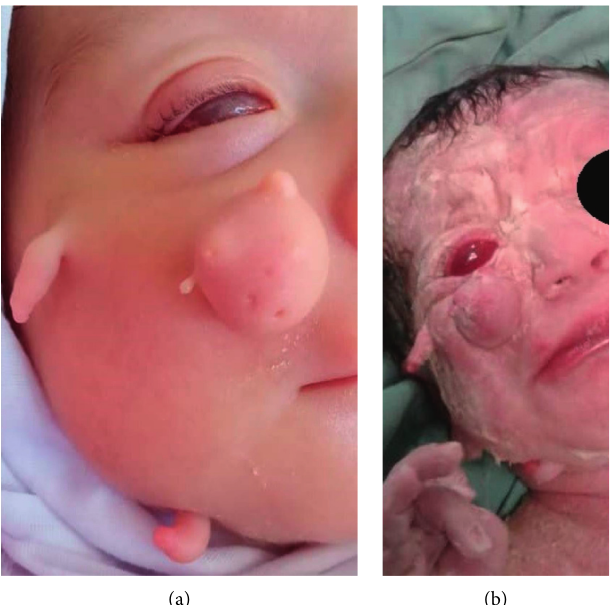
Figure 1: Multiple cutaneous appendages on the right side of the face and a fleshy mass under the right